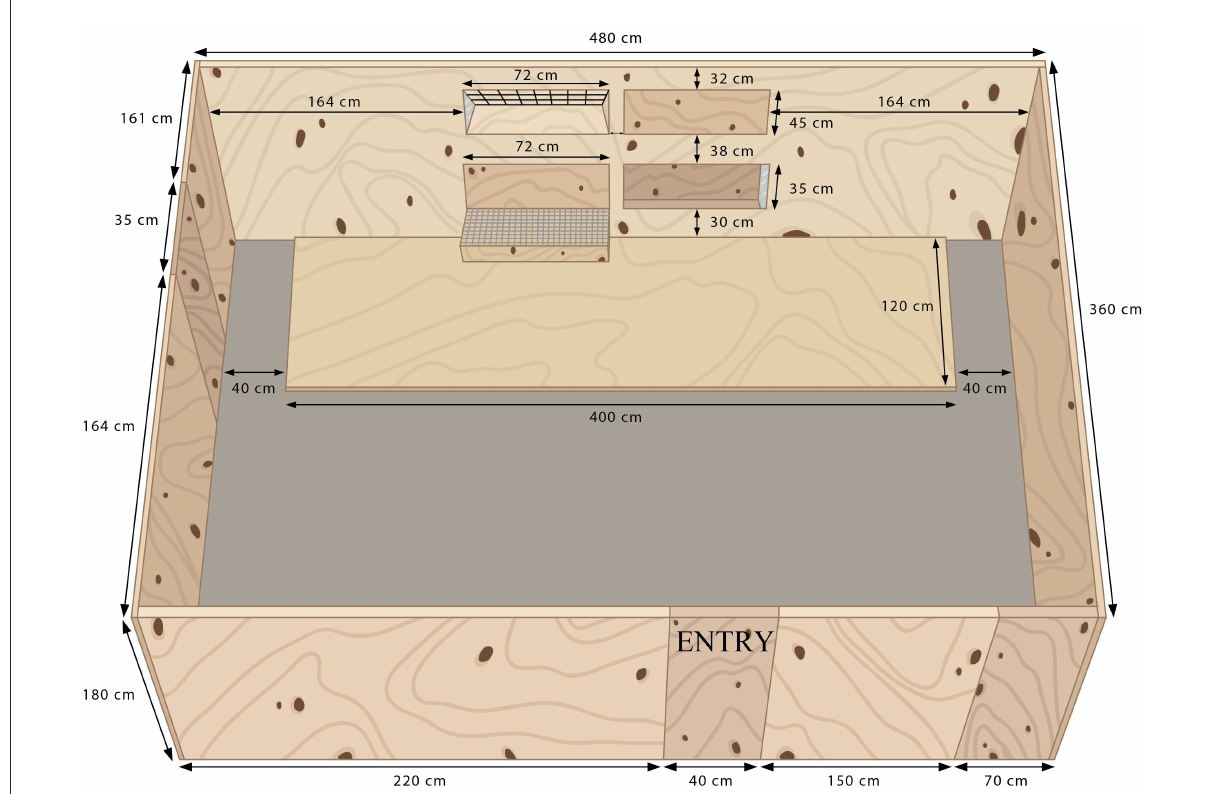
FIGURE1 Layout of the testing arena with solid plywood walls and a concrete floor that was partially covered by plywood directly in front of the feeders. It contained feeders which could be opened or closed (elevated feeders accessible by a movable step, floor-level feeders). All feeders were made of plywood boxes with a plate of acrylic glass at the end, but in the elevated feeder the feed was placed on steel mesh forming a 75 ◦ angled with the bottom of the feeder (Figure 2). For each 10-min test, two different feeders were opened. The combination of feed type (poplar leaves or cut grass) and feeder position (elevated feeder and floor-level feeder), and the side of the feeder were changed for each goat. The step was covered with a mesh (chicken wire) to prevent slipping.